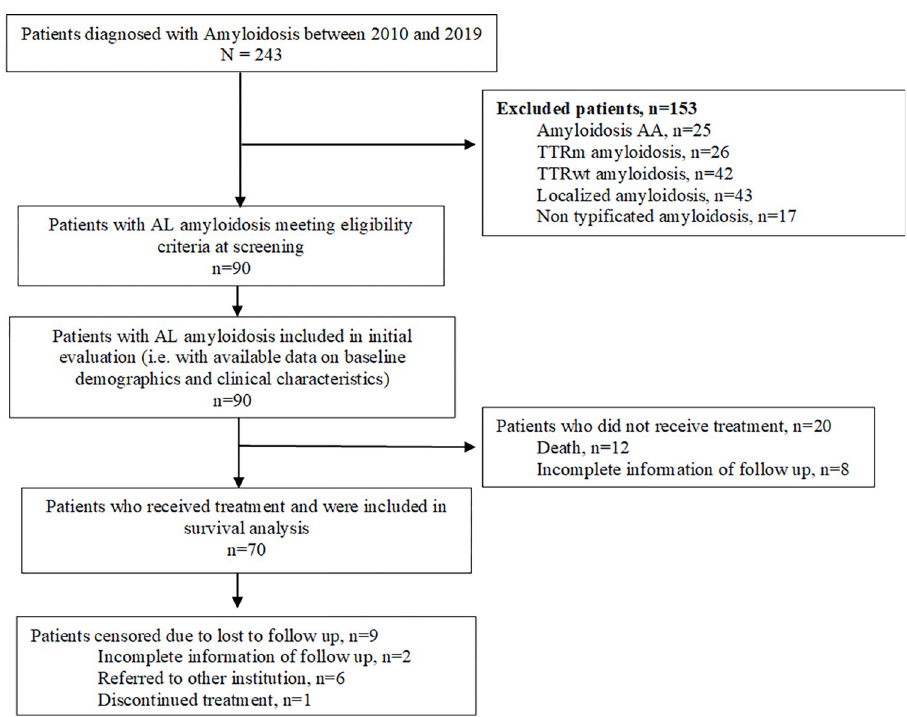
Fig 1. Patient disposition flow chart. AA amyloidosis: Serum amyloid A amyloidosis; AL amyloidosis: Light chain amyloidosis; TTRm amyloidosis: Mutational transthyretin amyloidosis; TTRwt: Wild type transthyretin amyloidosis.